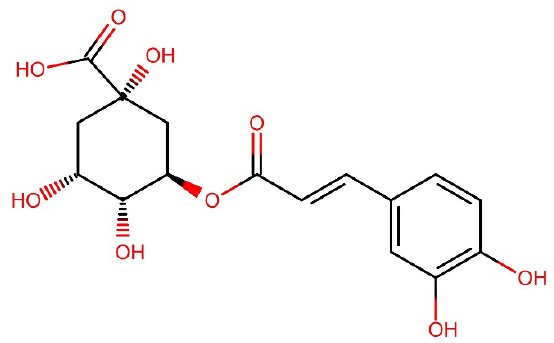
Figure 1. Chemical structure of 5-coffeolquinic acid.